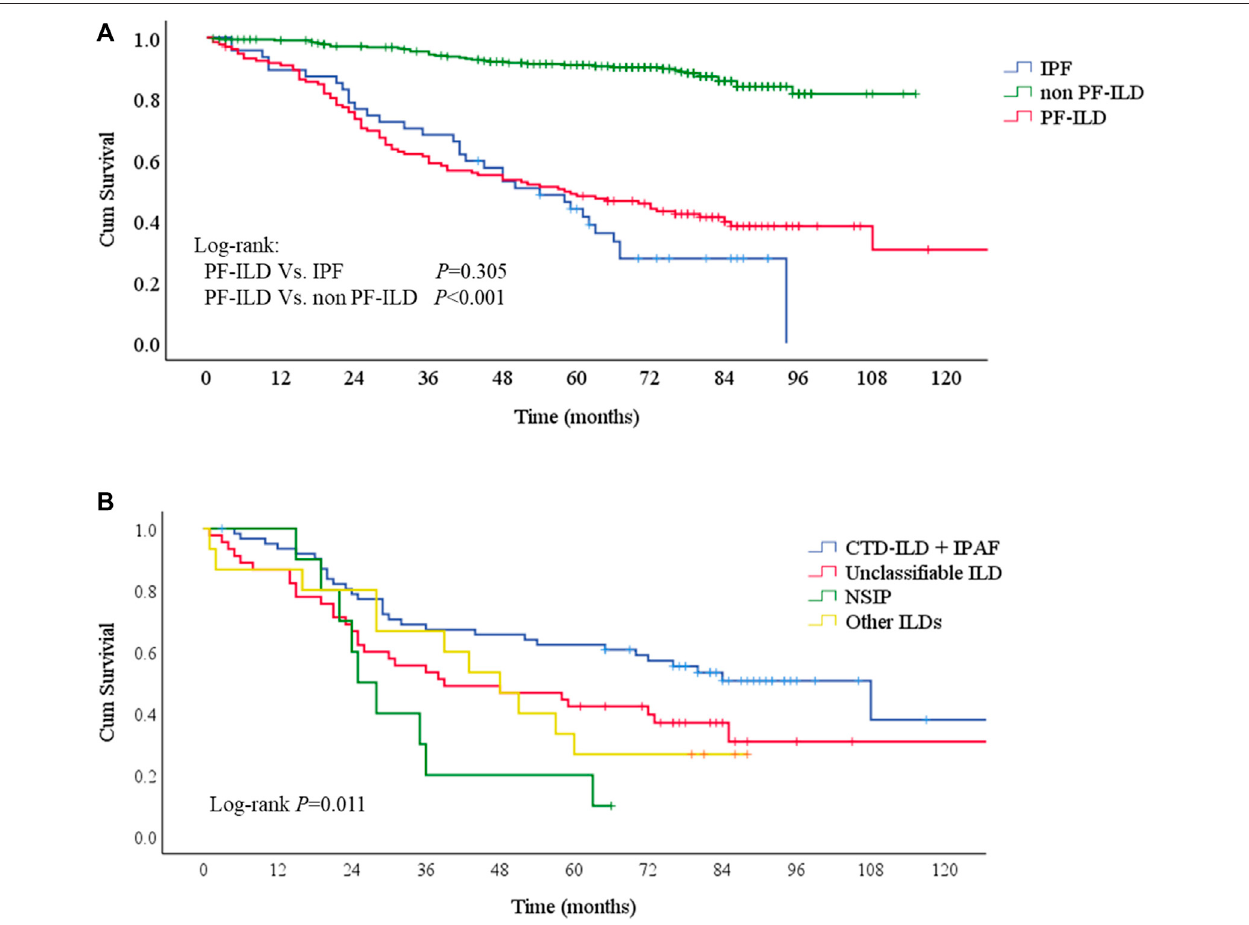
FIGURE3| SurvivalcurvesofPF-ILD (A) Survival curvesofPF-ILD,nonPF-ILDandIPF. Kaplan-Meier survivalanalysisshowednodifferencebetweenPF-ILDand IPF group ( p (cid:1) 0.305). But signi fi cantdifference was seen in PF-ILD group and non PF-ILD group ( p < 0.001). The median survival times were 54 (95%CI: 39-69) and 58 (95%CI: 37-79) months in IPF and PF-ILD group respectively, NA in non PF-ILD group (B) Survival curves of subgroups of PF-ILD. Kaplan-Meier survival analysis showing a signi fi cant difference between groups ( p (cid:1) 0 001), a higher mortality in NSIP subgroup and a lower mortality in CTD-ILD + IPAF subgroup. The median survival times were 108 (95%CI: 64-152), 39 (95%CI: 4-74), 25 (95%CI: 19-31), 48 (95%CI: 33-63) months in CTD-ILD + IPAF, Unclassi fi able ILD, NSIP and other ILDs groups respectively.; Abbreviations: PF-ILD, progressive fi brosing interstitial lung disease; IPF, idiopathic pulmonary fi brosis; CTD-ILD, connective tissue disease- associated interstitial lung disease; IPAF, interstitial pneumonia with autoimmune features; NSIP, nonspeci fi c interstitial pneumonia.